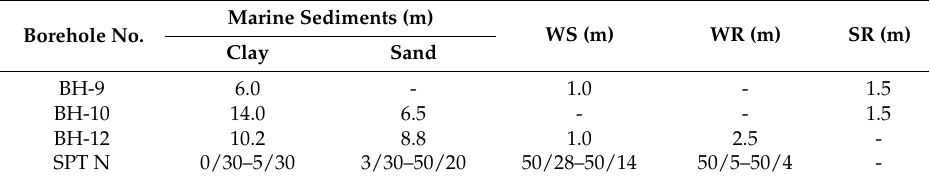
Table 1. The soil profile and the result of standard penetration test (SPT). Borehole No.